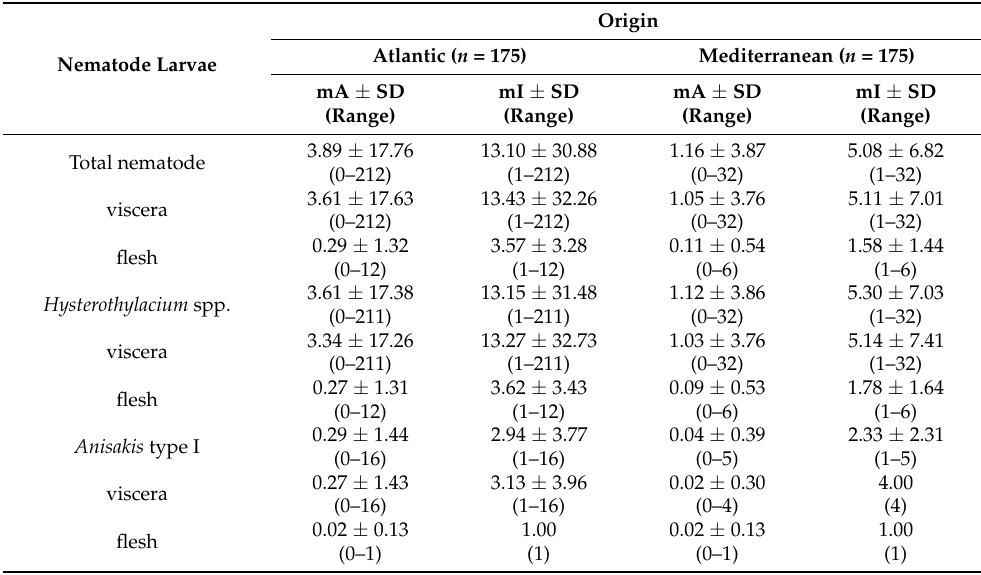
Table 3. Mean abundance (mA), mean intensity (mI), standard deviation (SD) and range of nematode larvae in sardines according to their origin of